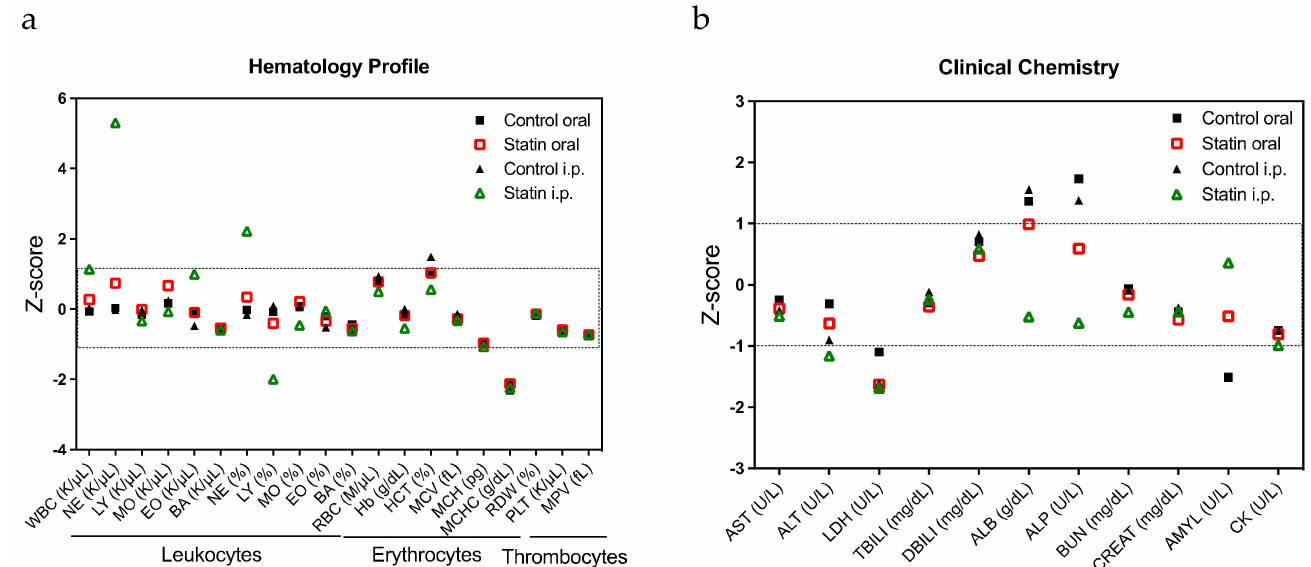
Figure 4. Hematological toxicity in mogp-Tag mice treated with lovastatin. ( a ) Hematology profile. ( b ) Clinical